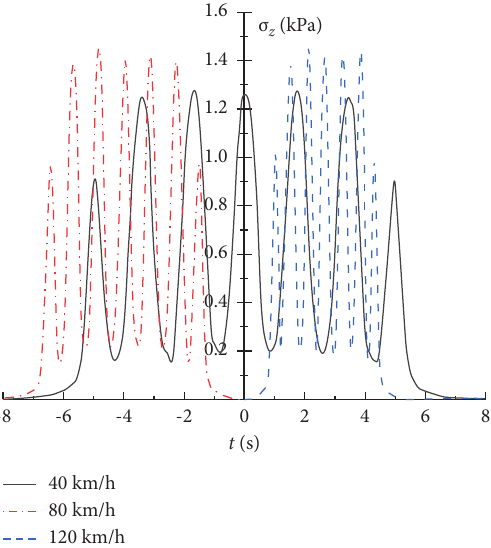
Figure 9: σ z of soil at different